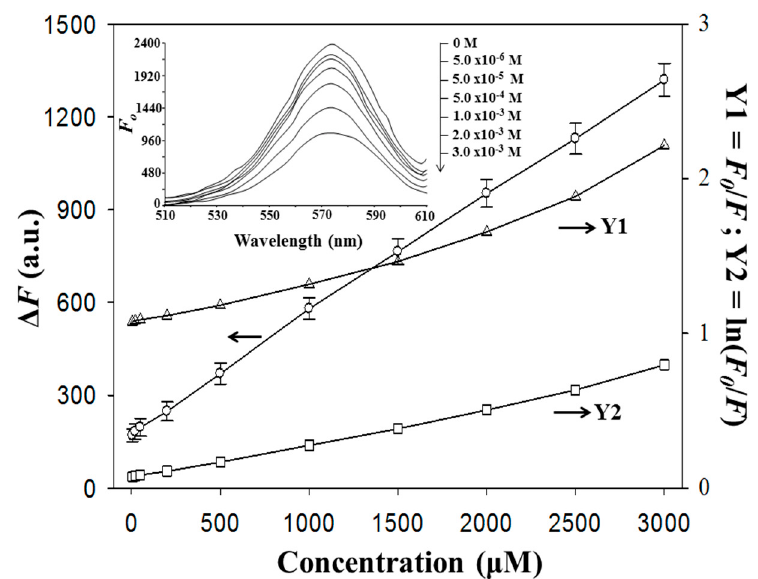
Figure 6. Correlation of the Tc concentration with the ( MIP-plasma-PIs in phosphate bu ff er (pH 7.6, 50 mM). The insert shows the fluorescence spectra at di ff erent concentrations of Tc.